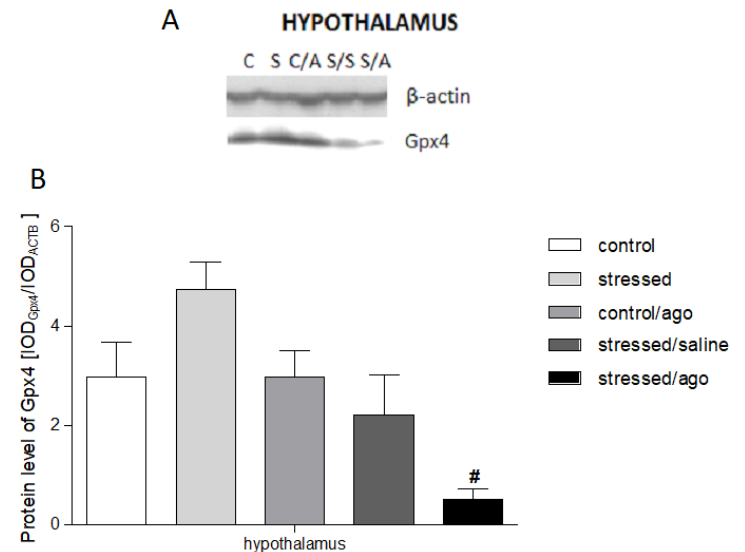
Figure 5. Gpx4 protein expression in the brain structures — hippocampus, amygdala, hypothalamus, midbrain, cerebral cortex and basal ganglia — of animals exposed to CMS procedure for two weeks (Control, Stressed) and in animals exposed to CMS procedure for seven weeks and administered vehicle (1 mL / kg) or agomelatine (10 mg / kg) for five weeks (Control / Ago, Stressed / Saline, Stressed / Ago). ( A ) Representative Western blot analysis in midbrain and cerebral cortex. C—controls, S—stressed for two weeks, C / A—Control / Agomelatine, S / S—Stressed / Saline, S / A—Stressed / Agomelatine. ( B ) Gpx4 protein level measured in all studied brain structures. The graphs show the mean integrated optical density (IODs) of the bands from all analyzed samples. The relative protein expression levels was calculated using the IOD gene / IOD ACTB method. Data are presented as means ± SEM. N = 6. # p < 0.05 for the di ff erence between stressed and stressed / ago